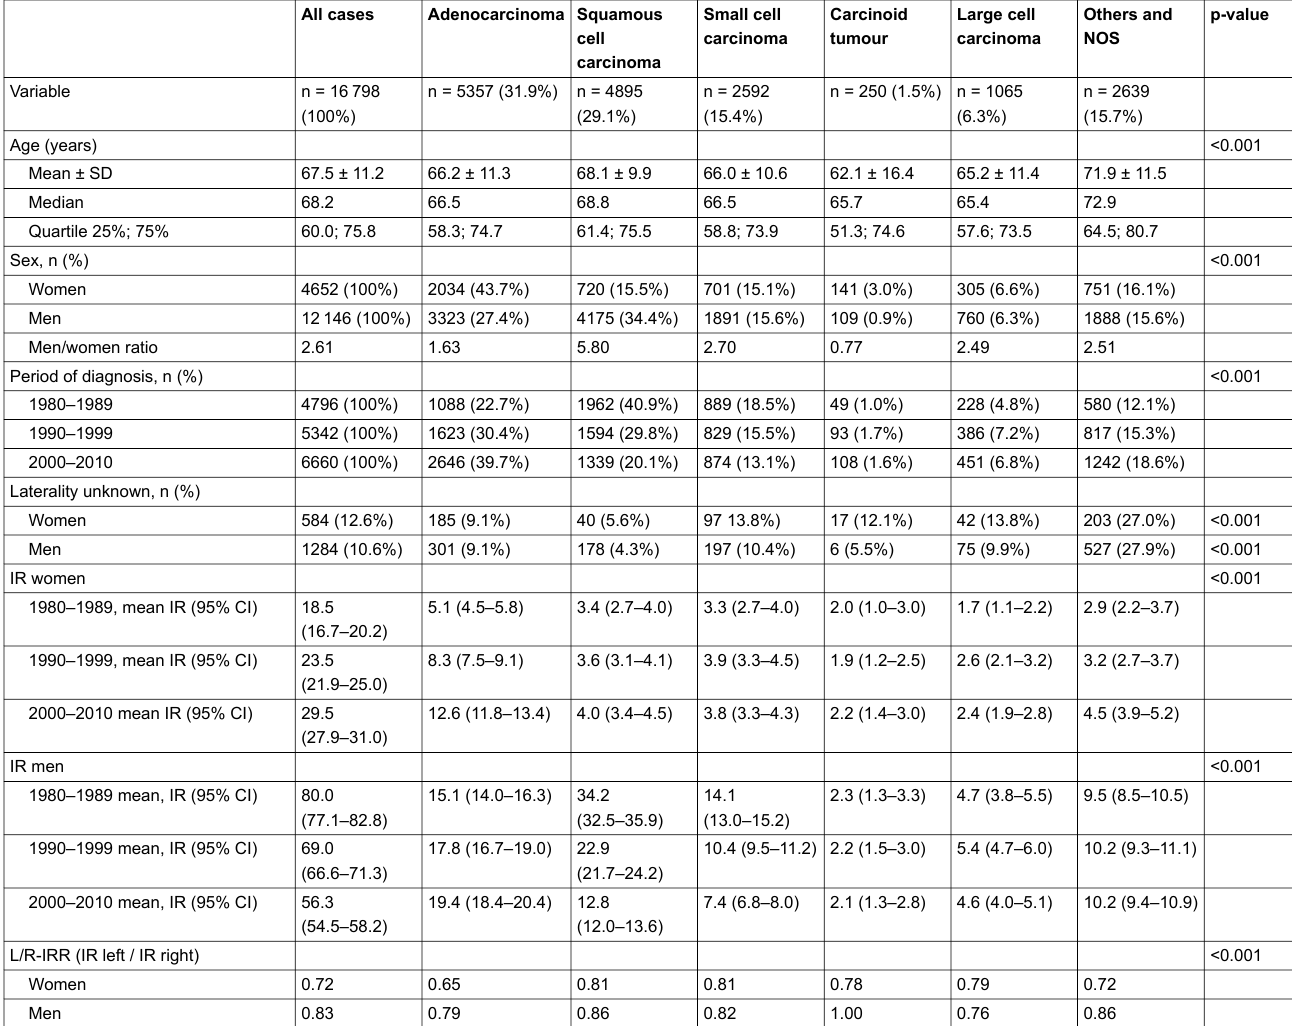
Table 1: Characteristics of primary incident lung cancer cases diagnosed in the Canton of Zurich 1980–2010. All